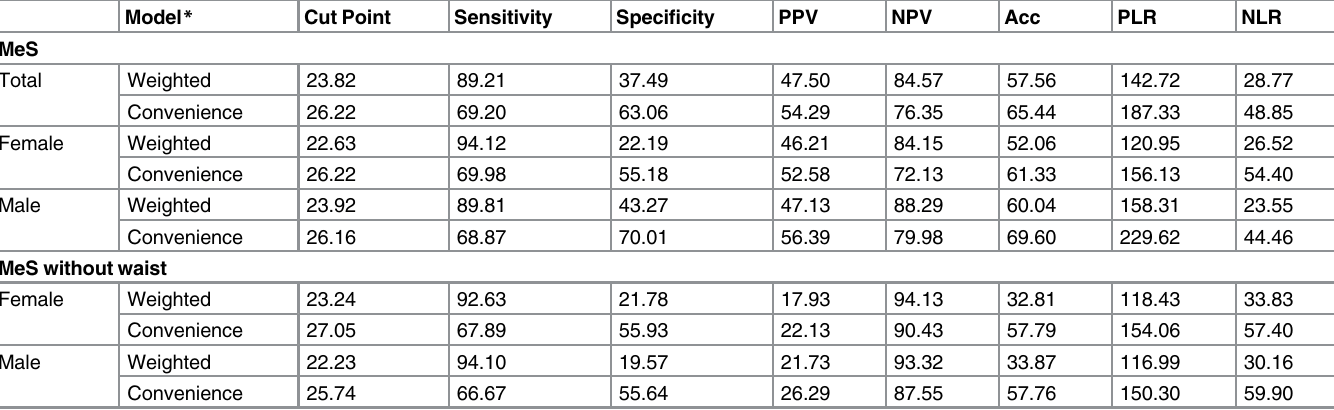
BMI: Body mass index; MeS: Metabolic syndrome; PPV: Positive predictive value; NPV: Negative predictive value; Acc: Accuracy; PLR: Positive likelihood ratio; NLR: Negative likelihood ratio * Two models were de fi ned for the calculation of BMI cut-off points. In the weighted model, optimum cut-off was de fi ned as the point on the ROC curve with minimum [(1 – sensitivity)2 + (1 – speci fi city)2]. In the convenience model, optimum cut-off was de fi ned as the point on the ROC curve with the maximum sensitivity + speci fi city.